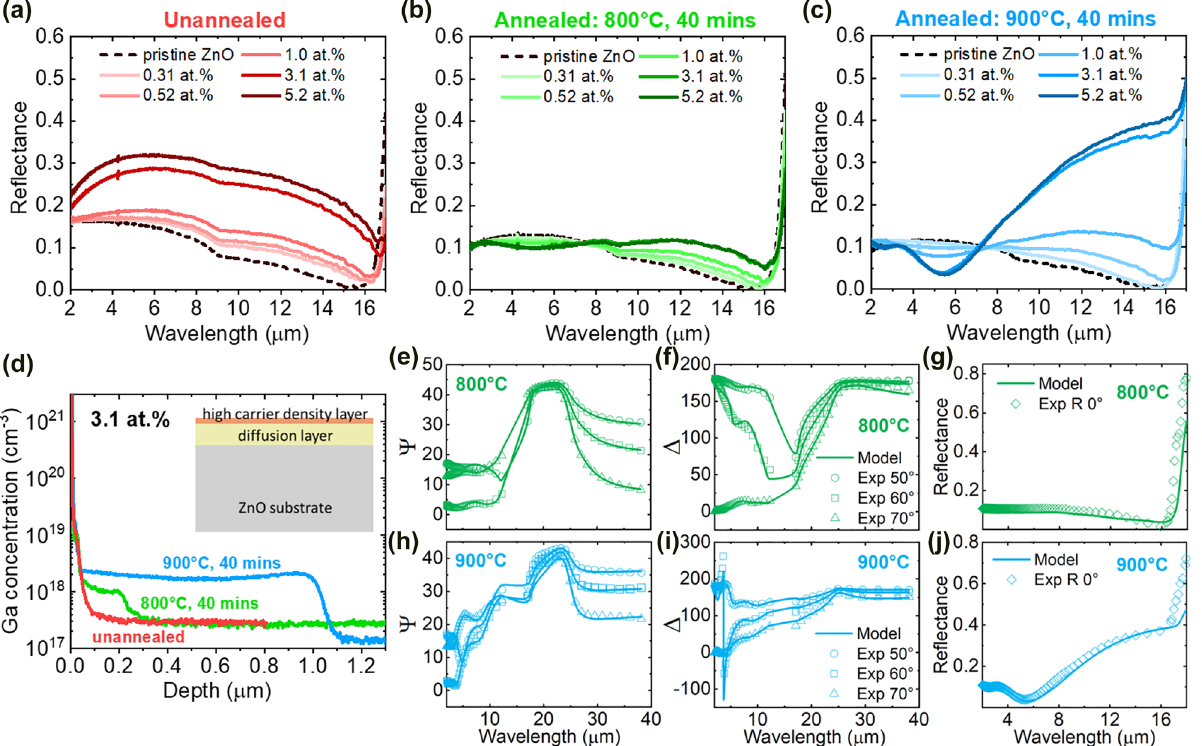
Figure 2: Measured normal-incidence reflectance for undoped ZnO, and FIB-irradiated ZnO regions with different ion fluences. (a) without annealing treatment, (b) followed by annealing in air at 800 ◦ C and (c) 900 ◦ C, respectively, for 40 min. (d) SIMS depth profiles of the Ga concentration in the samples implanted using an ion accelerator (not a FIB, to enable very large area implantation for infrared ellipsometry and SIMS). The ion energy was identically 30 keV and the peak doping concentration was chosen to be 3.1 at.%. The inset is the schematic showing the three-layer depth profile of thermal annealed FIB-ZnO. (e-j) The experimental (discrete points) and model fitted (solid curves) ellipsometric parameters ( Ψ and Δ ) and normal-incidence reflectance for the 3.1 at.% sample annealed at 800 ◦ C (e-g) and for the other one annealed at 900 ◦ C